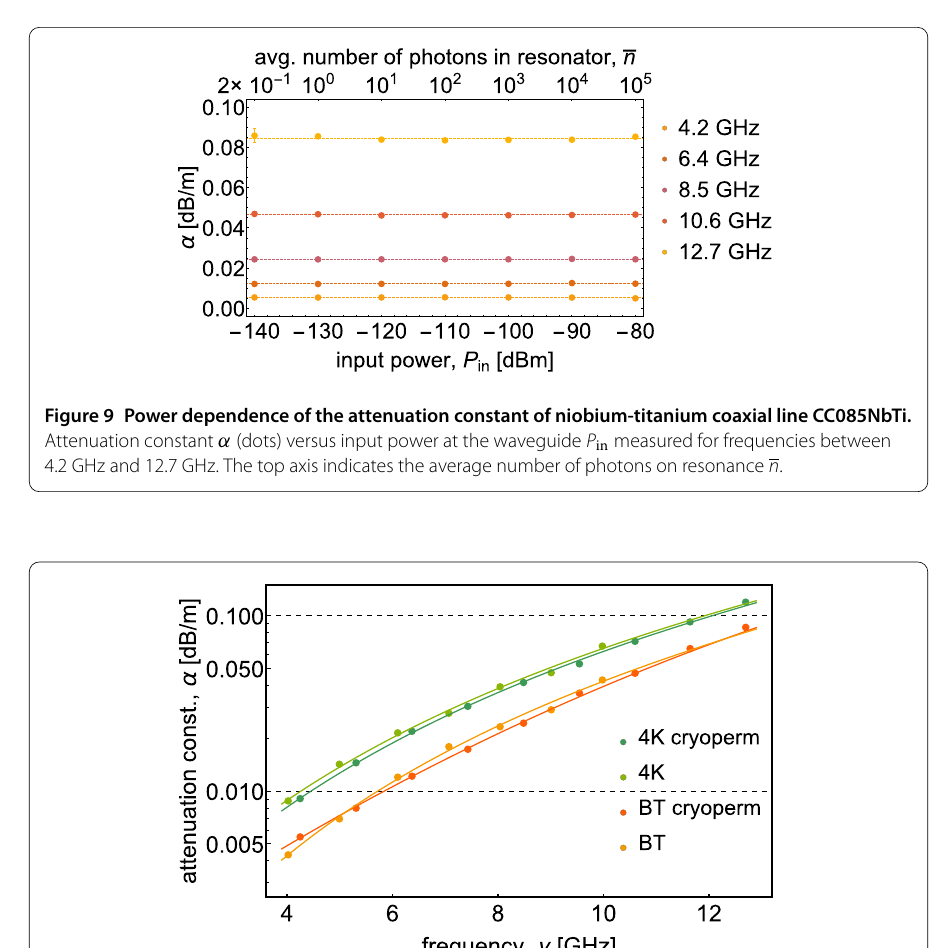
resonance inside the resonator of   to . and an average resonator voltage (cid:8) V  (cid:9) /